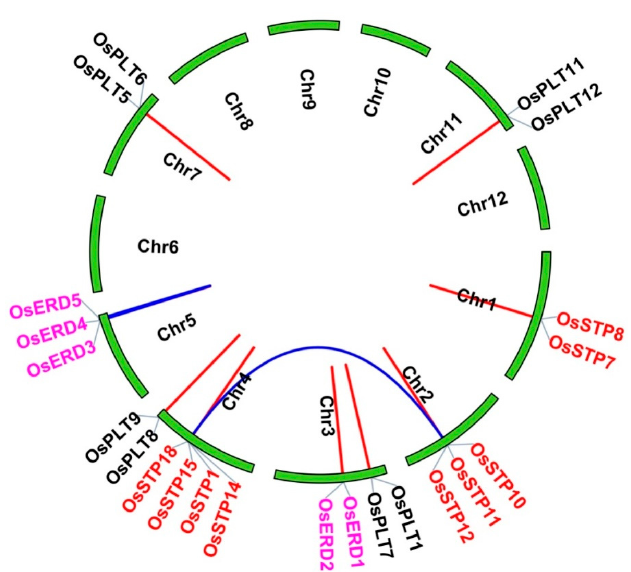
Figure 3. Duplication events of the monosaccharide transporter (MST) genes in rice. Different colors of genes represent the members from different subfamilies. The duplicate gene pairs of WGD or segmental/tandem events are shown with blue/red lines. Table 2. Ka, Ks and Ka/Ks values for duplication gene pairs in